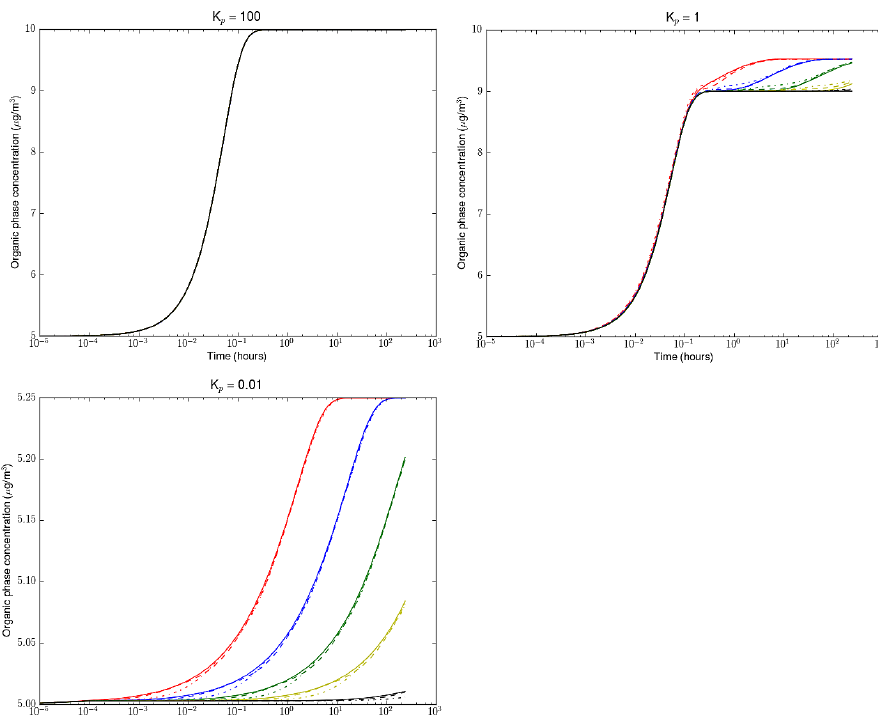
Figure 6. Comparison between the explicit representation (plain lines) and the implicit representation for N layer = 5 (– line) and N layer = 4 (-. line) for several organic-phase diffusivity: D org = 10 − 19 m 2 s − 1 (red), D org = 10 − 20 m 2 s − 1 (blue), D org = 10 − 21 m 2 s − 1 (green), condensing on 5µgm − 3 of non-volatile organic